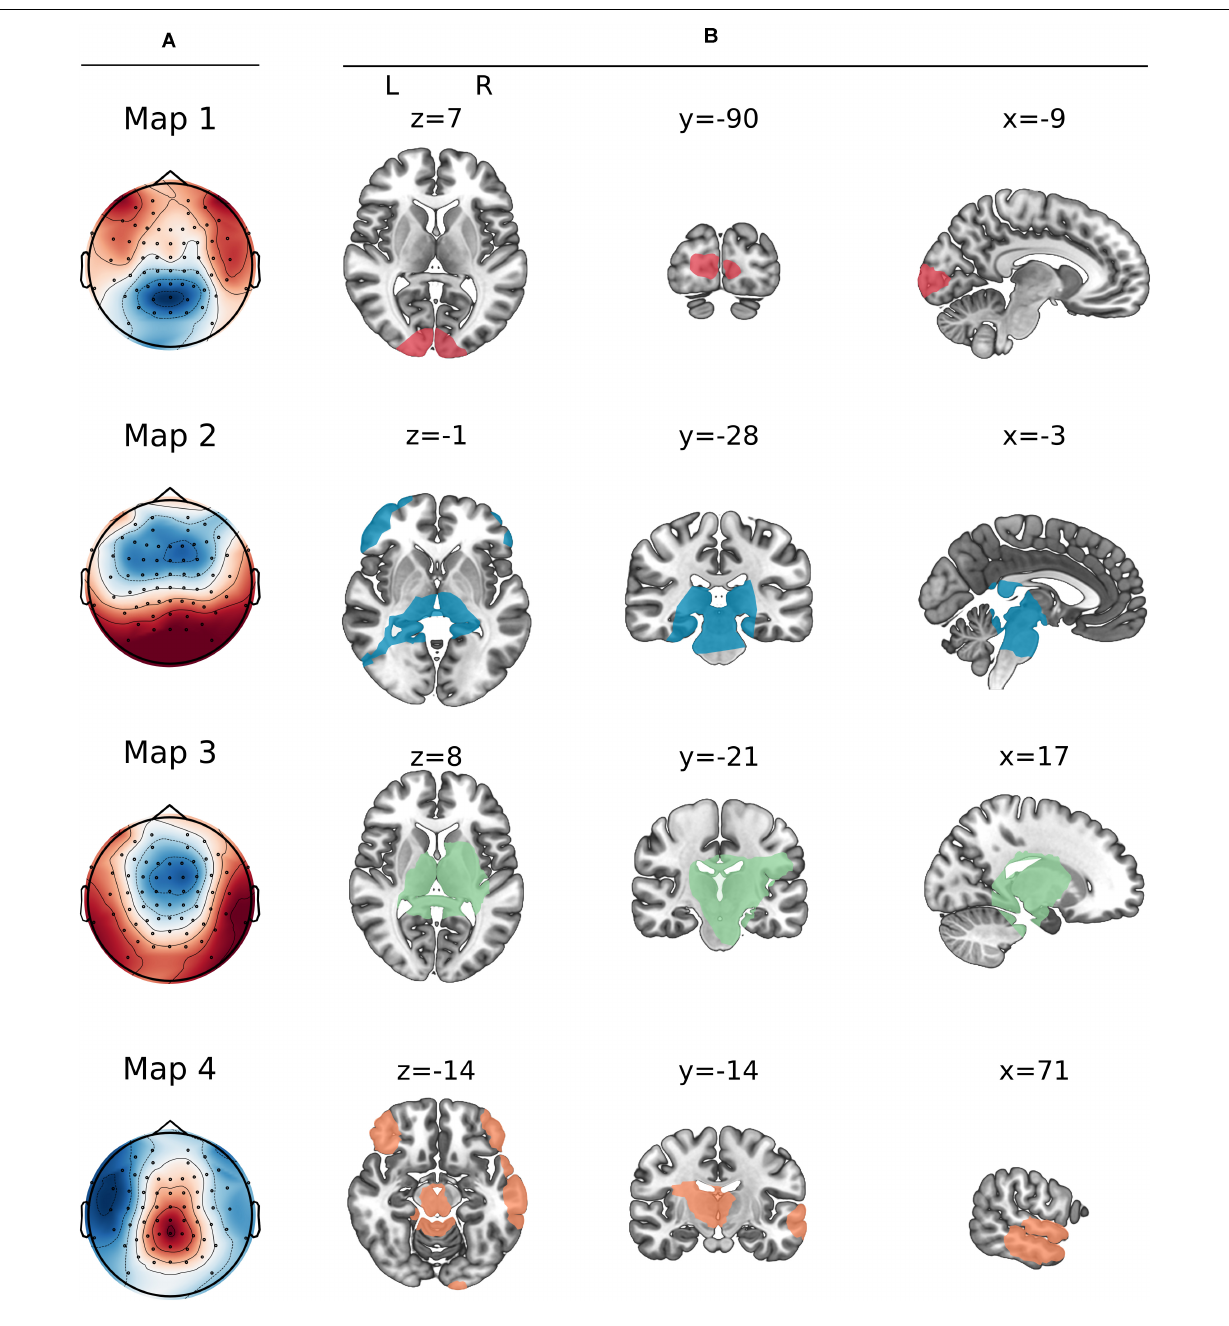
FIGURE 3 | Prototype maps resulting from the clustering step. (A) Map topographies of the four prototype maps. (B) Source localization of the maps. X, Y, and Z correspond to coordinates in MNI